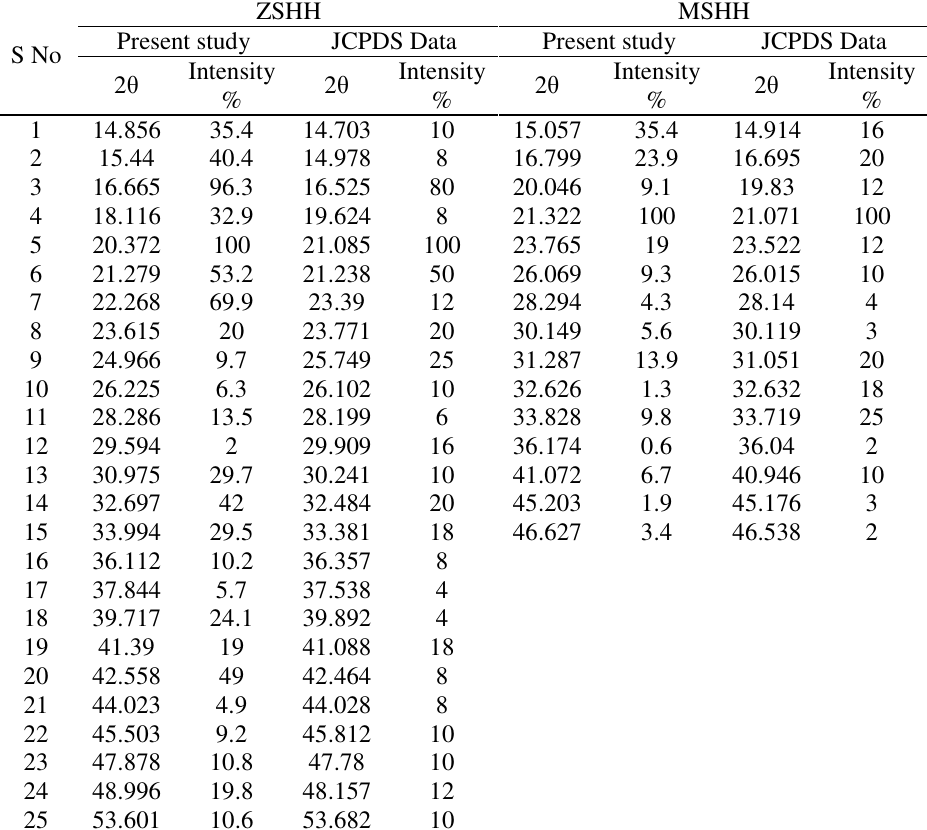
Table 3. Variation of lattice parameter and lattice volume of the grown crystals